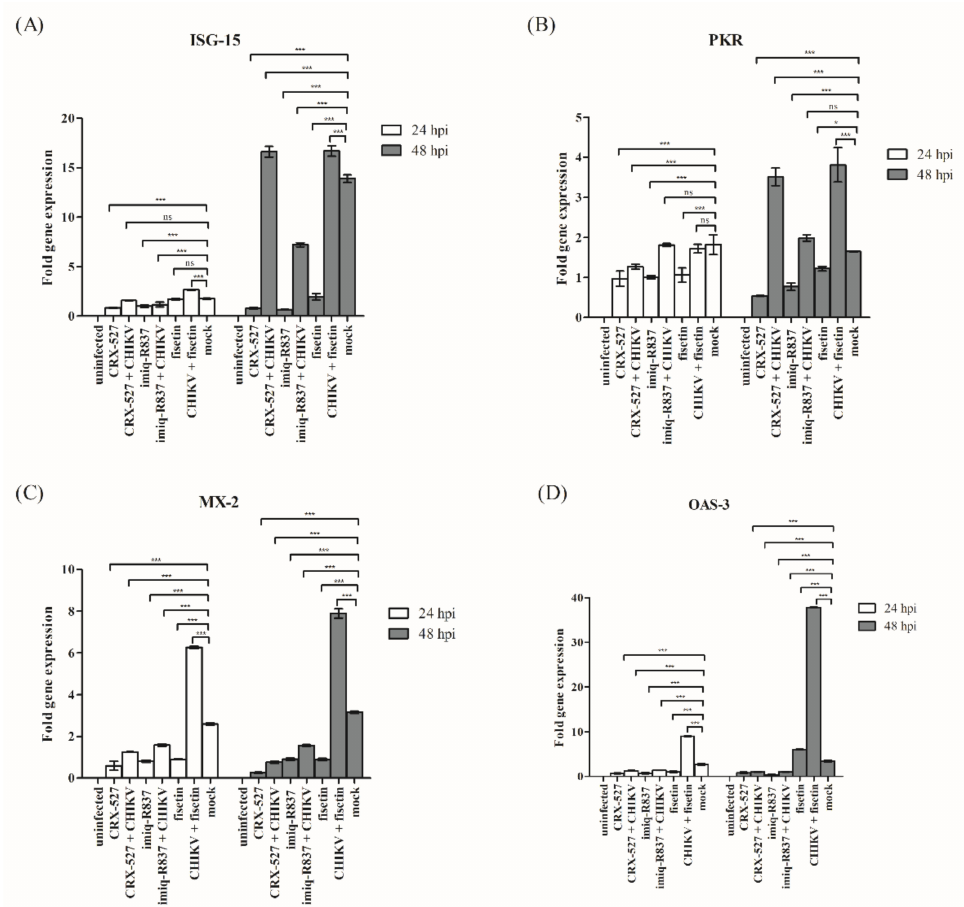
Figure 4. Gene expression profile of antiviral genes. ( A ) ISG-15, ( B ) PKR, ( C ) MX-2, and ( D ) OAS-3 in CHIKV-infected Huh7 cells at 24 hpi and 48 hpi. The data are normalized to human GAPDH mRNA and are expressed as a relative fold increase over normalized RNA from uninfected (2 − ∆∆ Ct method). CHIKV infection was performed using MOI = 1. Data are representative of three independent experiments and values are expressed as mean ± SD. One-way ANOVA ( p < 0.0001) and Dunnett multiple comparison post-test (* is p < 0.05, and *** is p < 0.001) were performed by setting uninfected and mock Huh7 cells of respective time points as an independent